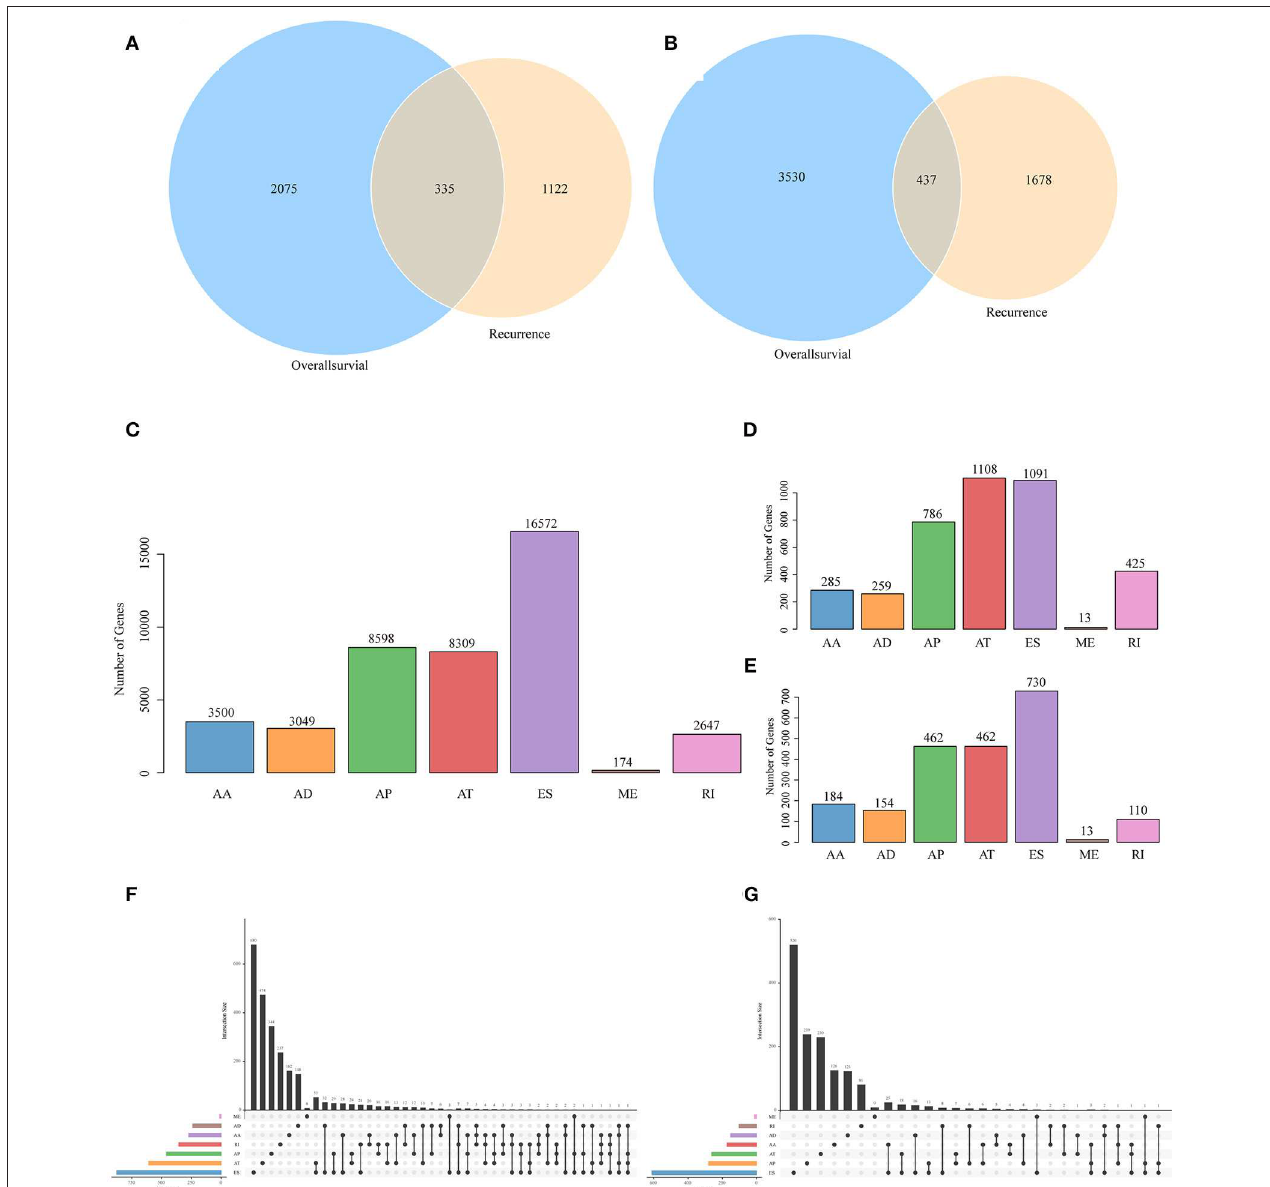
FIGURE 2 | Venn diagram of AS events (A) and involved genes (B) that were significantly correlated with OS and recurrence. (C) Distribution of AS events of seven types. (D) Distribution of OS-associated AS events of seven types. (E) Distribution of recurrence-associated AS events of seven types. The UpSet intersection diagram shows seven types of OS (F) —and recurrence (G) —associated AS events in HNSCC. One gene may have up to four types of alternative splicing associated with patient survival or